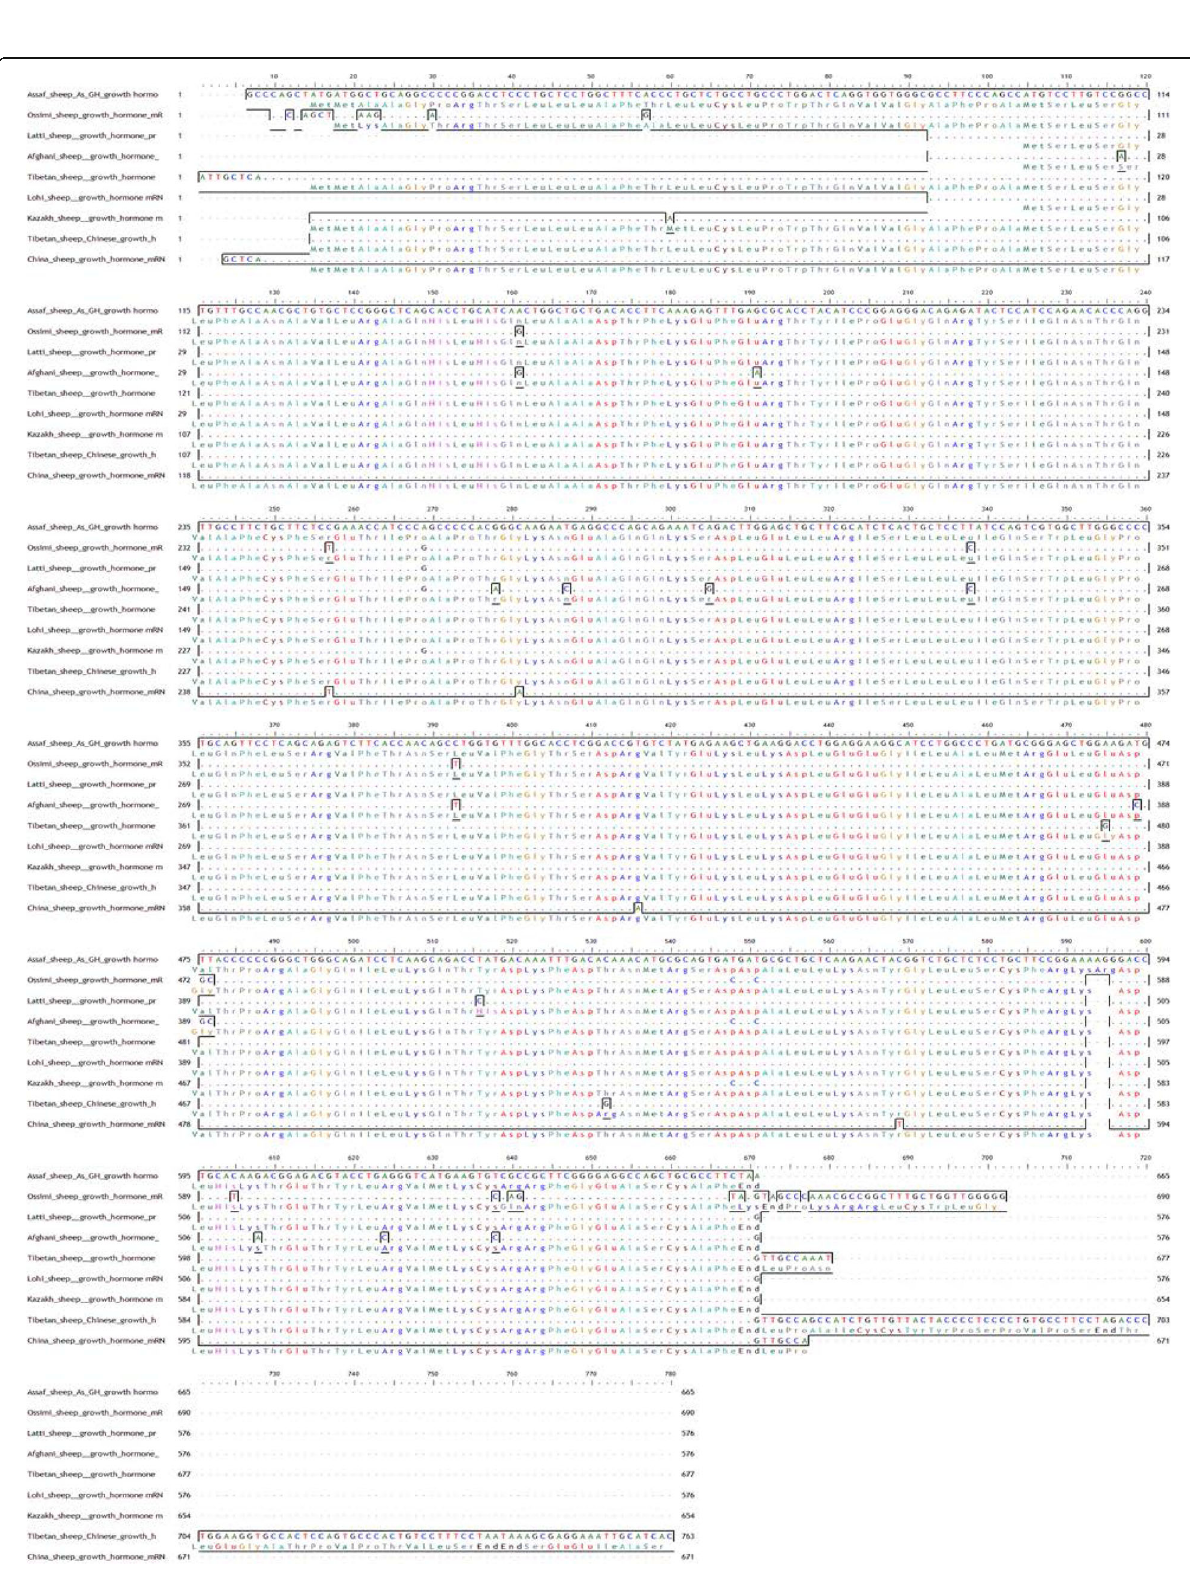
Fig. 6 Multiple alignments of Assaf_GH cDNA sequences with GenBank sheep